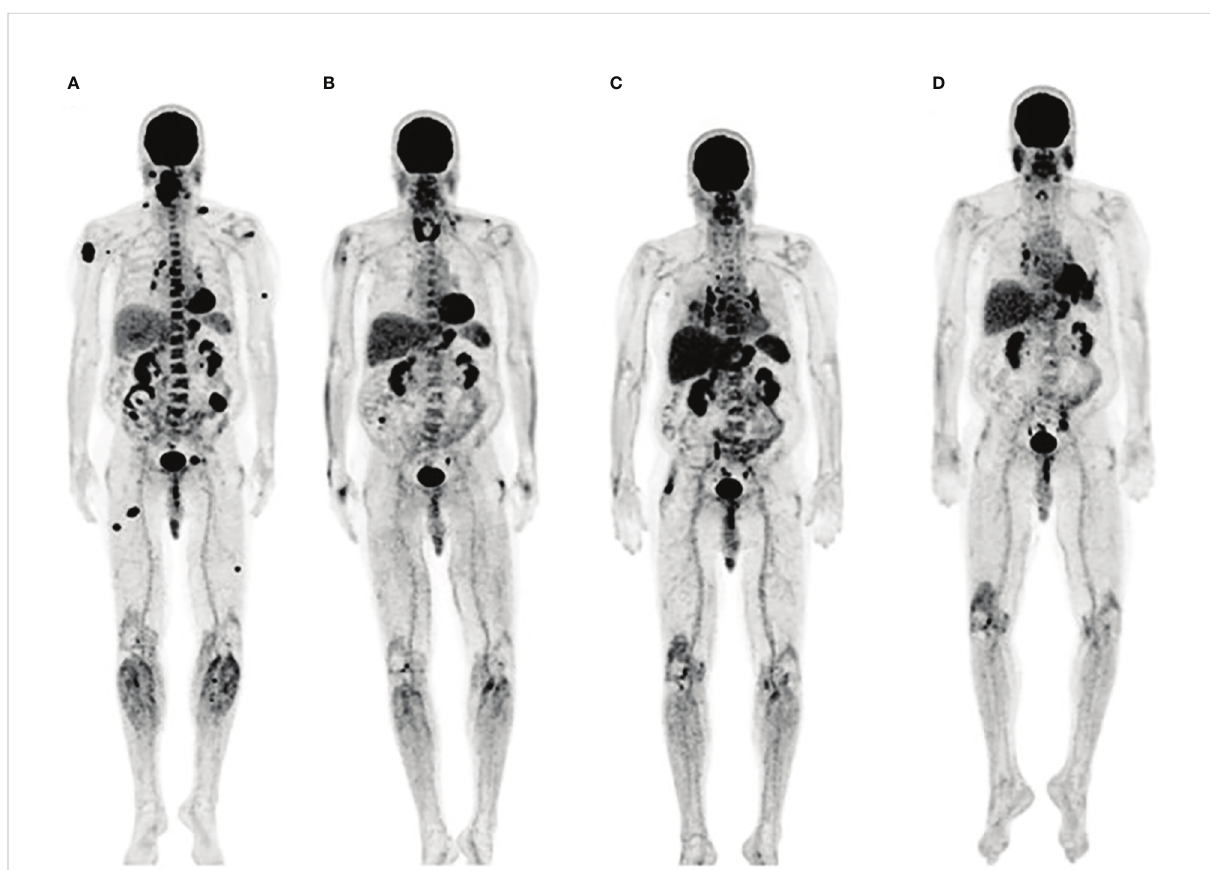
FIGURE 2 Immune related thyroiditis. (A) FDG scan of a metastatic melanoma patient prior to starting immunotherapy (B) Three months into anti-PD-1 therapy, FDG uptake in multiple metastatic lesions decreased while the signal in thyroid increased. Bilateral hilar adenopathy that developed after 6 months (C) , disappered at 9 months (D) . Adapted with permission from Wolters Kluwer Health, Inc. under the terms of CC-BY-NC-ND license: Nobashi T, Baratto L, Reddy SA, et al. Predicting Response to Immunotherapy by Evaluating Tumors, Lymphoid Cell-Rich Organs, and Immune- Related Adverse Events Using FDG-PET/CT. Clin Nucl Med. 2019;44:e272-e279.